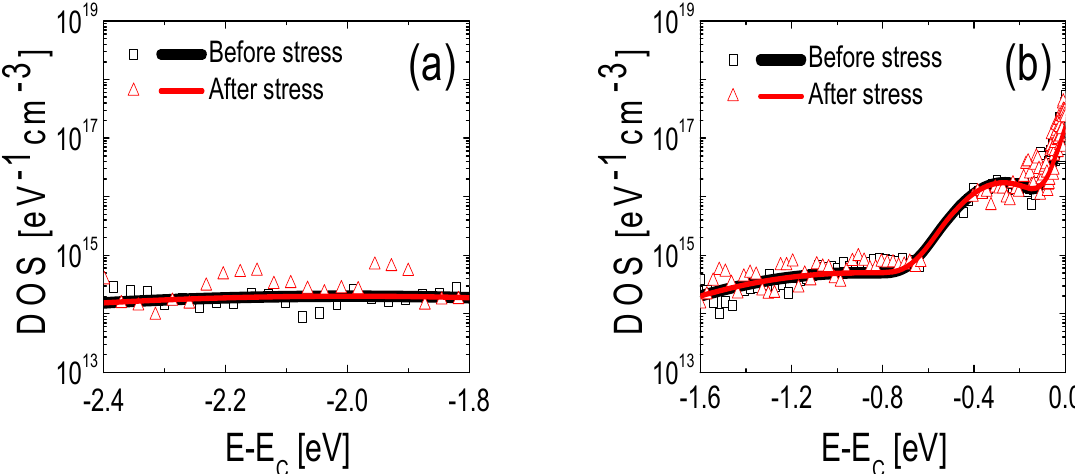
Figure 3. Energy distribution of subgap DOS in IGZO near ( a ) the valence band maximum ( E V ) and ( b ) the conduction band minimum ( E C ) obtained using MPCV before and after the application of the PBTS ( V GS = 40 V, V DS = 0 V, 80 °C) for 5000 s. Dotted symbols and lines denote the experimental data and fitting curves, respectively.